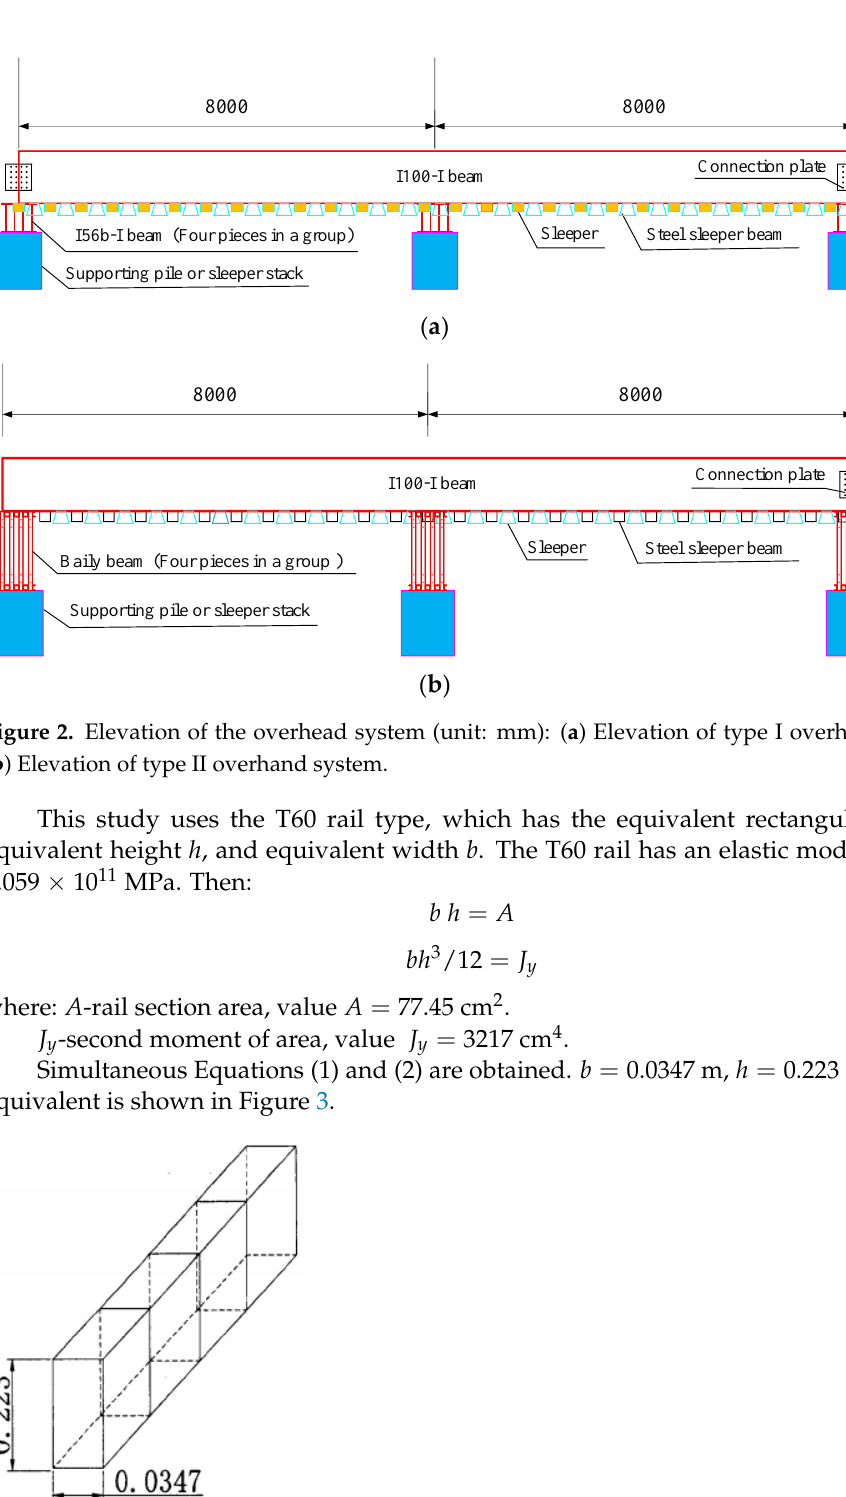
Figure 3. Model of equivalent rectangular rail beam (unit: m). The sleeper type is the speed-up line sleeper (type II), and the basic parameters are shown in Table